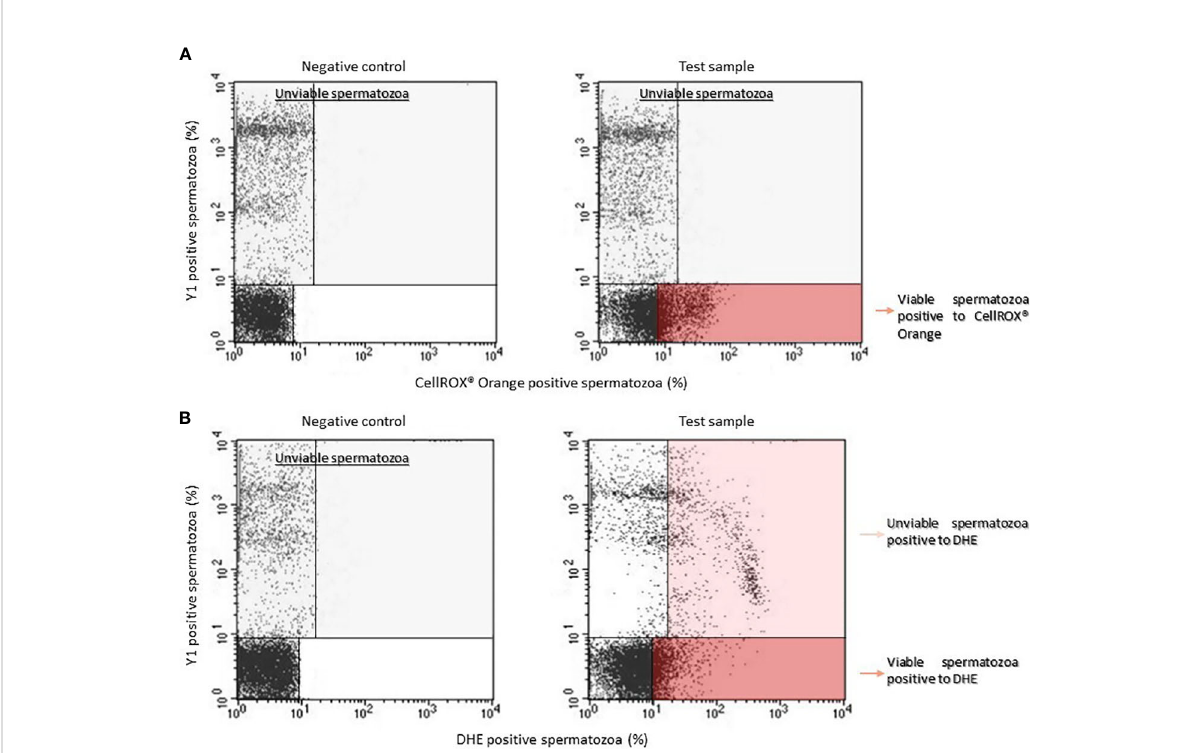
FIGURE 1 Typical dot plots representing negative control (left) and test sample (right) related to CellROX ® Orange (A) or DHE (B) and Y1 (ordinate, green fl uorescence) stained spermatozoa. Light grey rectangles contain dead spermatozoa (events positive to Y1) whereas dark red rectangles include the percentage of viable spermatozoa positive to CellROX ® Orange or DHE. Note that DHE stains also unviable spermatozoa (light red